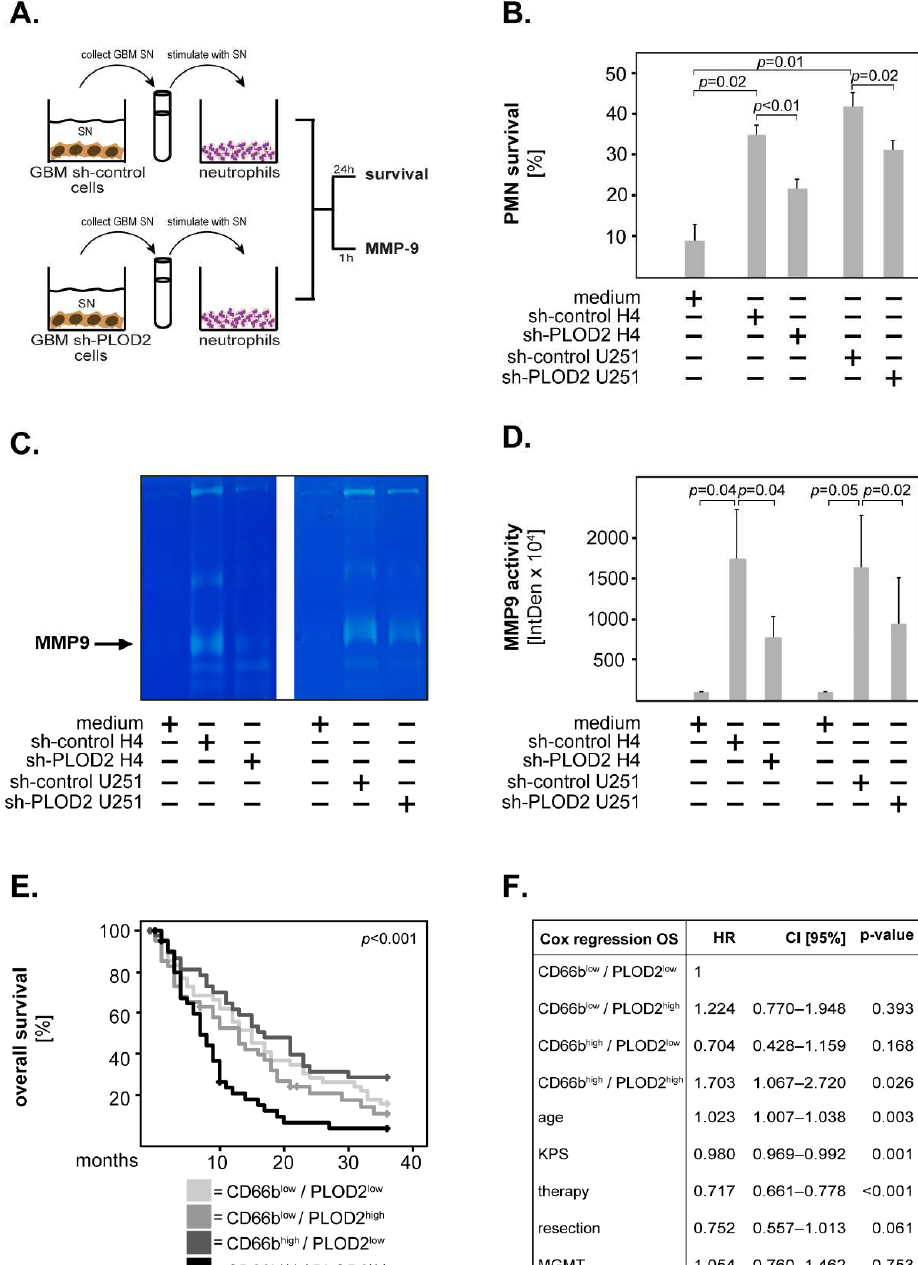
Figure 6. PLOD2 and neutrophils in GBM. ( A ) Neutrophils were incubated with supernatants (SN) derived from sh-control or sh-PLOD2 GBM cells. Culture medium was used as control. The survival of neutrophils was assessed at 24 h and the release of MMP9 at 1 h post-stimulation. ( B ) Sh-control SN prolonged the survival of neutrophils in both cell lines. This effect was significantly lower upon stimulation with PLOD2 knock-down SN. ( C ) Representative image of a gelatin zymography gel